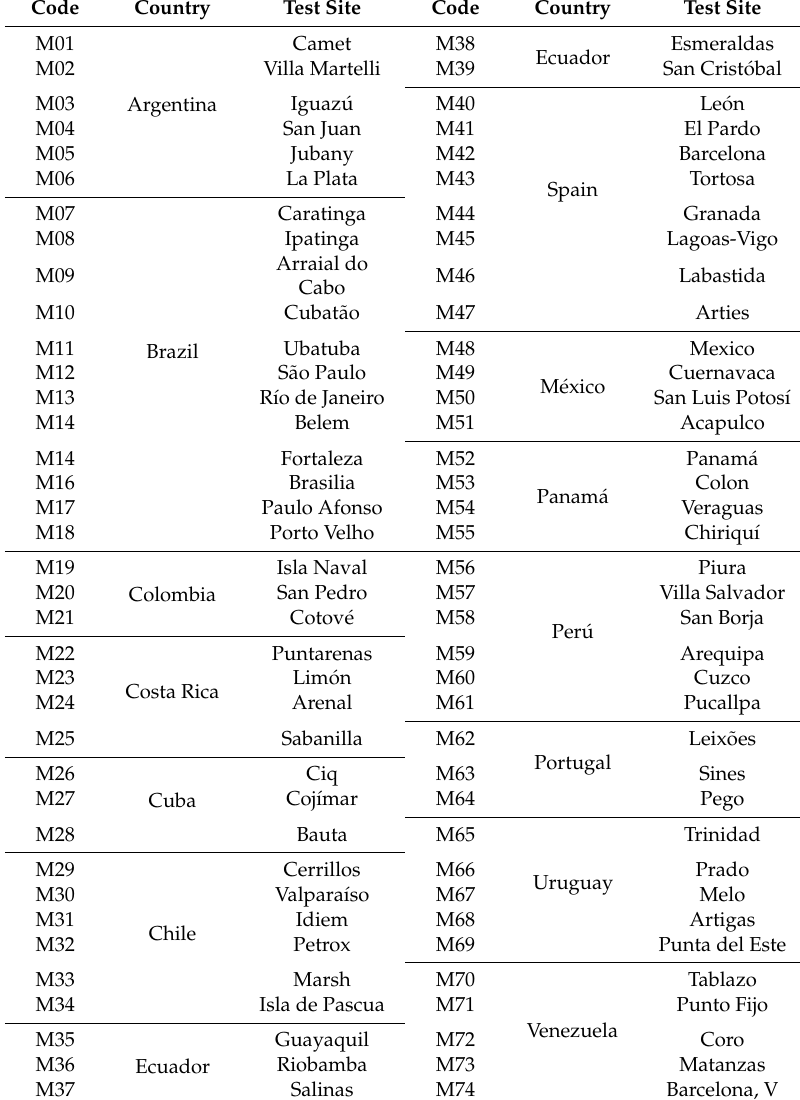
Table 3. Atmospheric corrosion test sites included in the MICAT